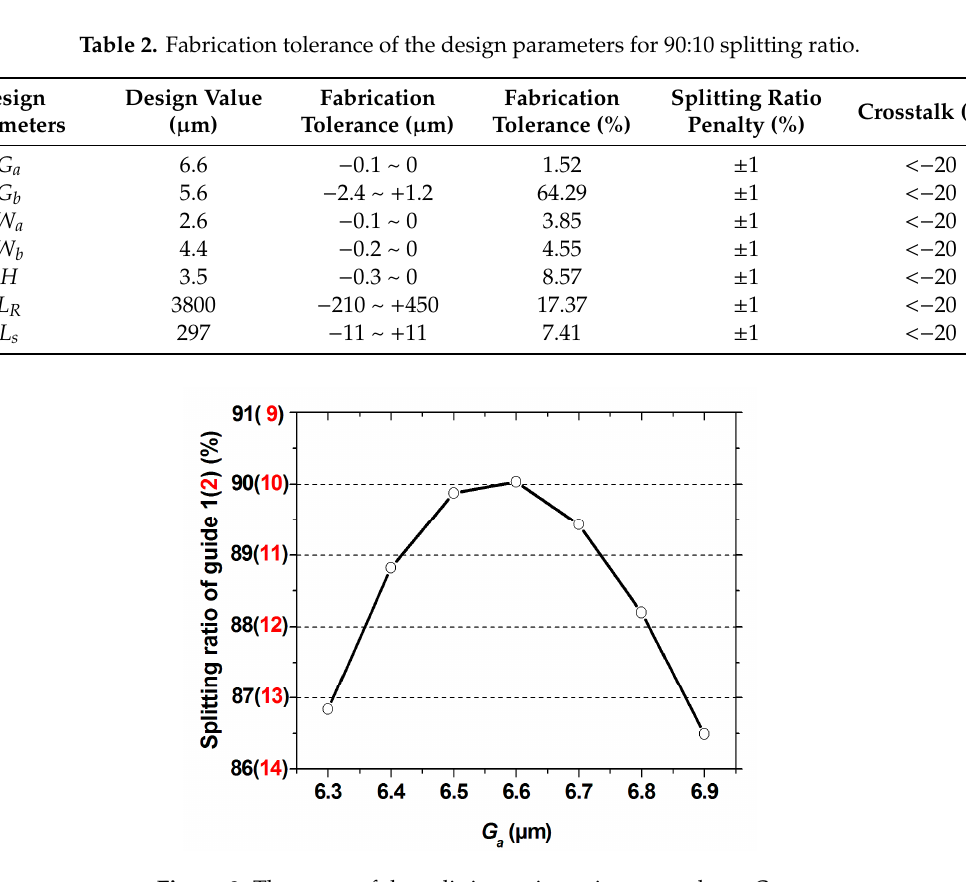
Table 1. Splitting ratios for various shifting length L s and optical performances characteristics.